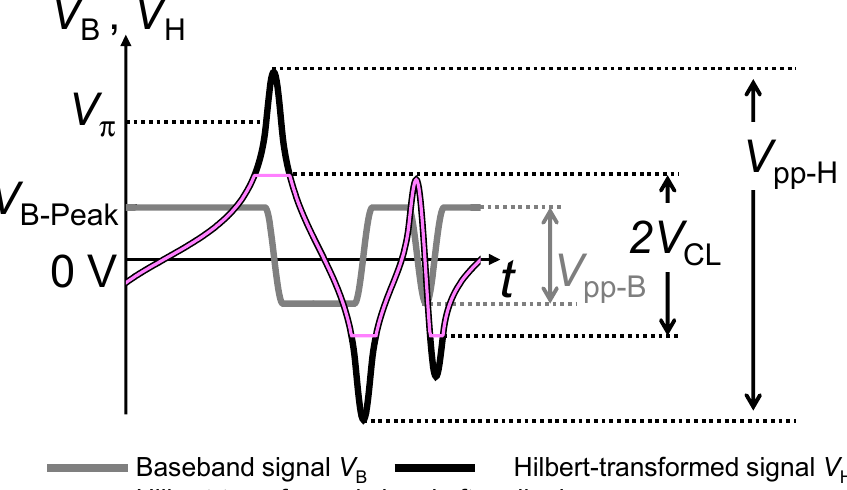
Figure 5. Peak clipping of Hilbert-transformed signal.